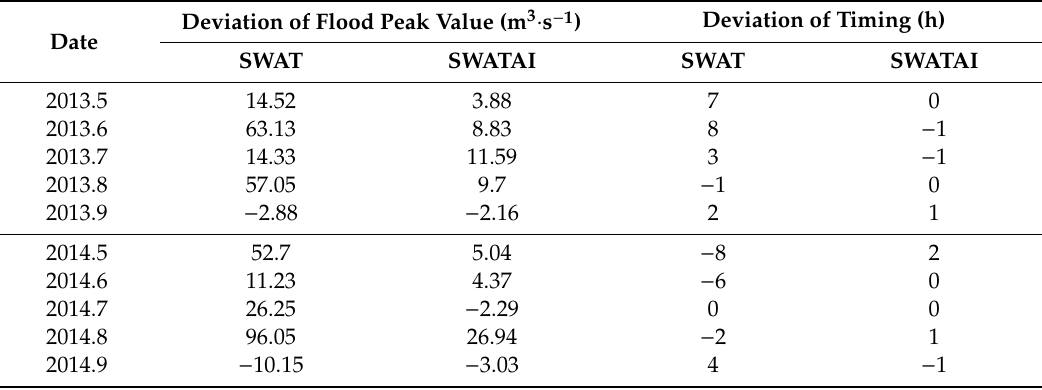
Table 3. Deviation statistics of peak flood processes before and after model